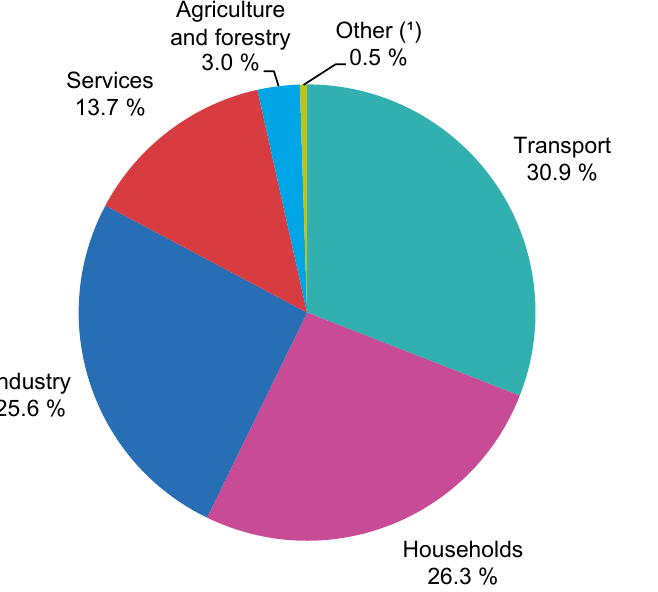
Figure 1. Final energy consumption by sector in the EU in 2019 expressed as a percentage of the total and based on tons of oil equivalent. The authors created this figure using data from Eurostat [1]. Notes: (1) International aviation and maritime bunkers are excluded from the Transport cate- gory.